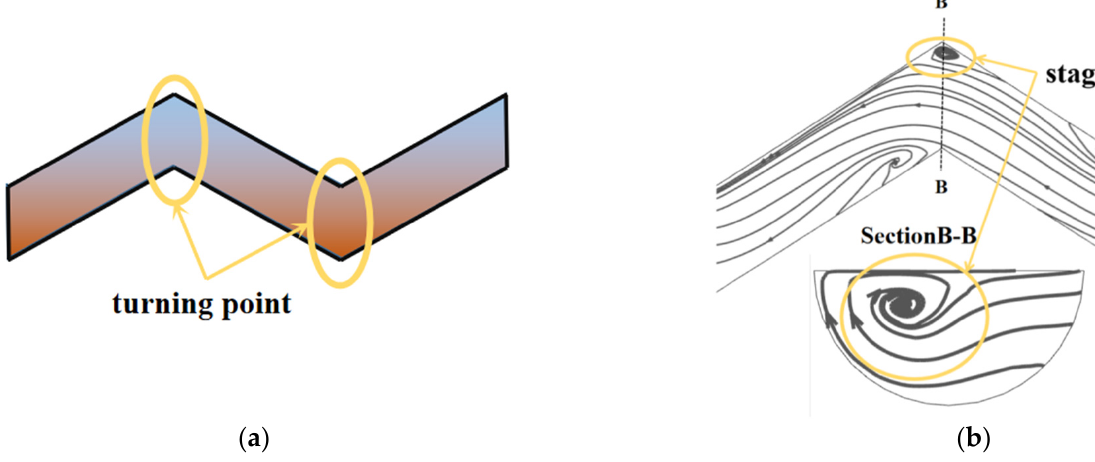
Figure 12. Relationship between the hot side pressure drop and angle θ of spiral structure.